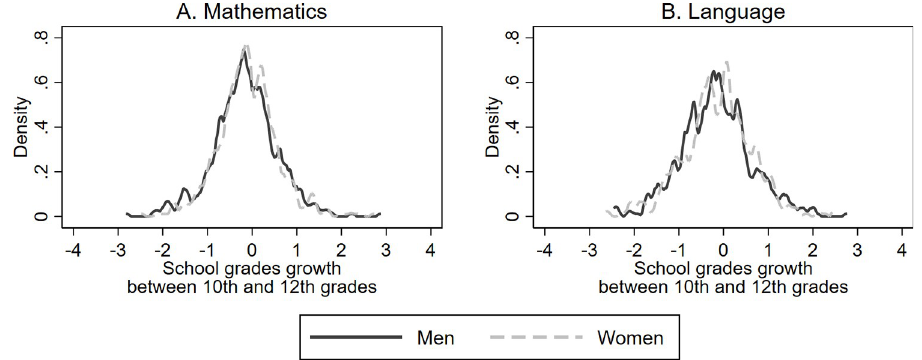
Fig 4. School grades growth between 10 th and 12 th grade by gender. Panel A shows the growth in Mathematics grades between 10 th and 12 th grade in men and women. Panel B shows the growth in Language grades between 10 th and 12 th grade in men and women. The grades are measured in standard deviation units, and the growth is calculated as 12 th grade scores minus 10 th grade scores.